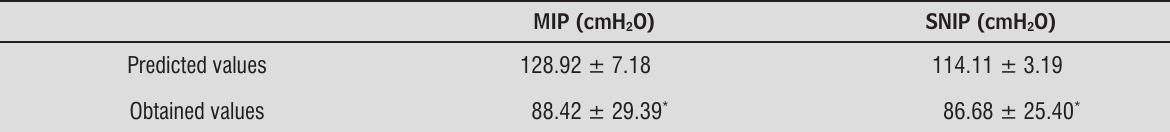
Table 2 - Maximal inspiratory pressure (MIP) and Sniff nasal inspiratory pressure (SNIP) predicted and obtained values